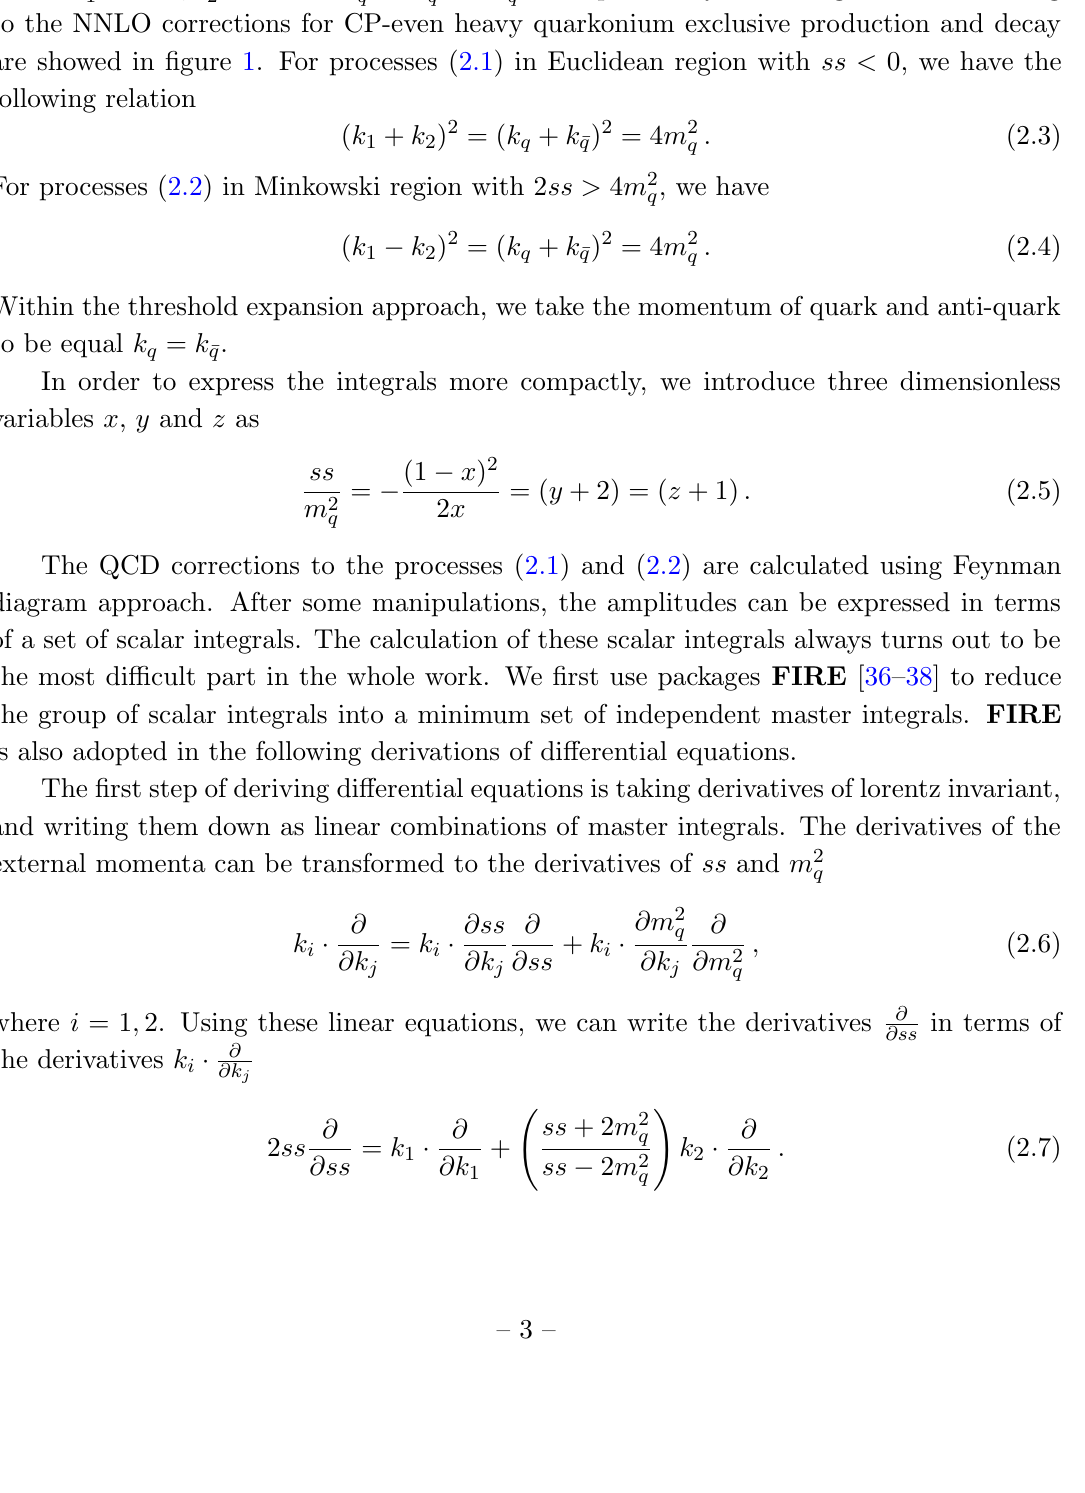
Figure 1. Sample of Feynman diagrams contributing to the two-loop QCD corrections of (cid:13) (cid:3) + (cid:13) Q (cid:22) Q and Q (cid:22) Q (cid:13) (cid:3) =(cid:13) + (cid:13) . ! ! where k 2 = 2 ss; k 2 = 0 and k 2 = k 2 = m 2 . Sample of Feynman diagrams q (cid:22) q q 1 2